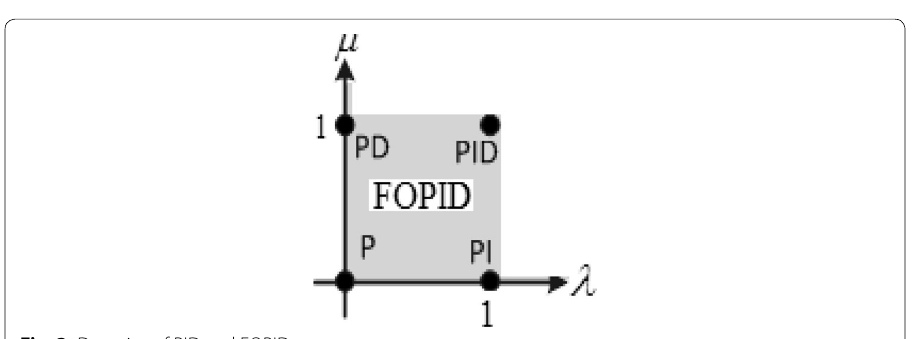
Fig. 3 Domains of PID and